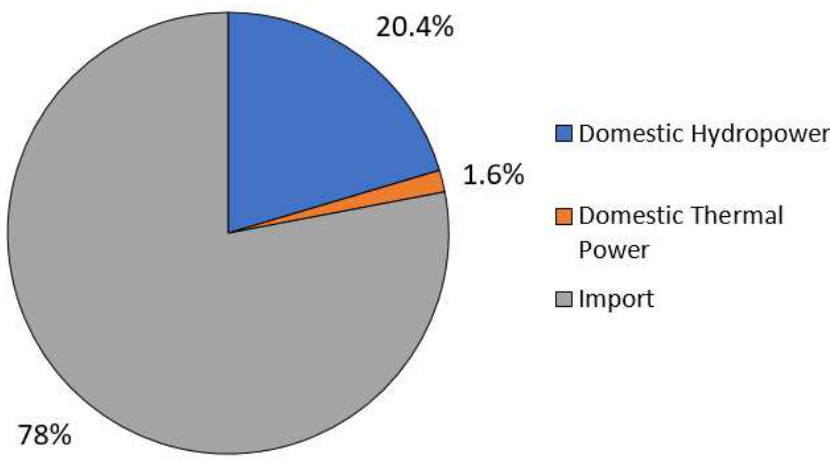
Figure 2. Share of energy sources in grid-connected generation of Afghanistan